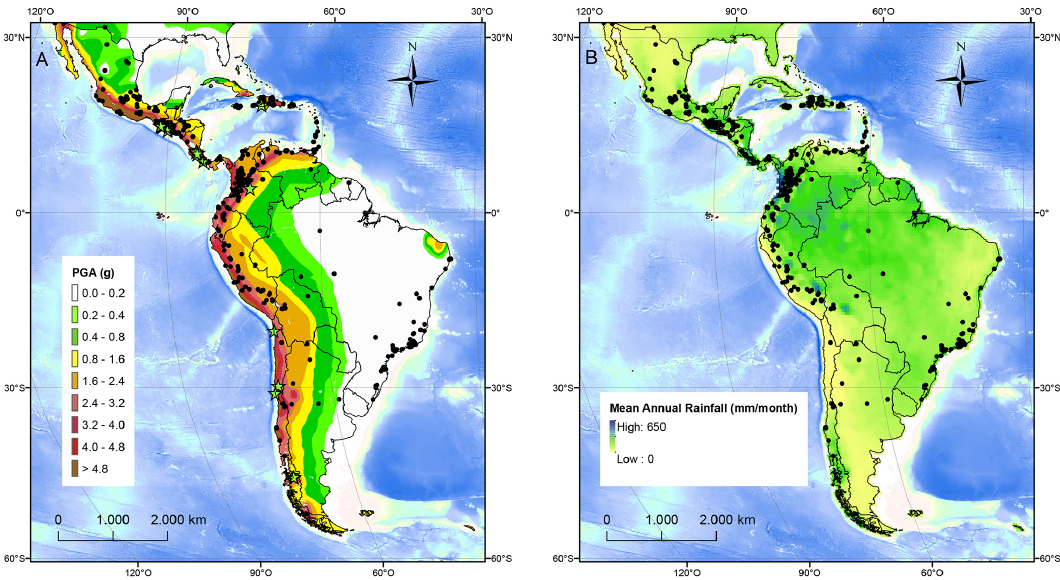
Figure 8. (a) GSHAP seismic hazard map (Giardini et al., 1999, 2003) compared with fatal landslide distribution (black dots). Green stars represent those fatal earthquake-induced landslides in the 2004–2013 period. (b) Mean annual precipitation (GPCC 0.5 ◦ data set, Schneider et al., 2011a) map and fatal landslides (black dots) for the 2004–2013